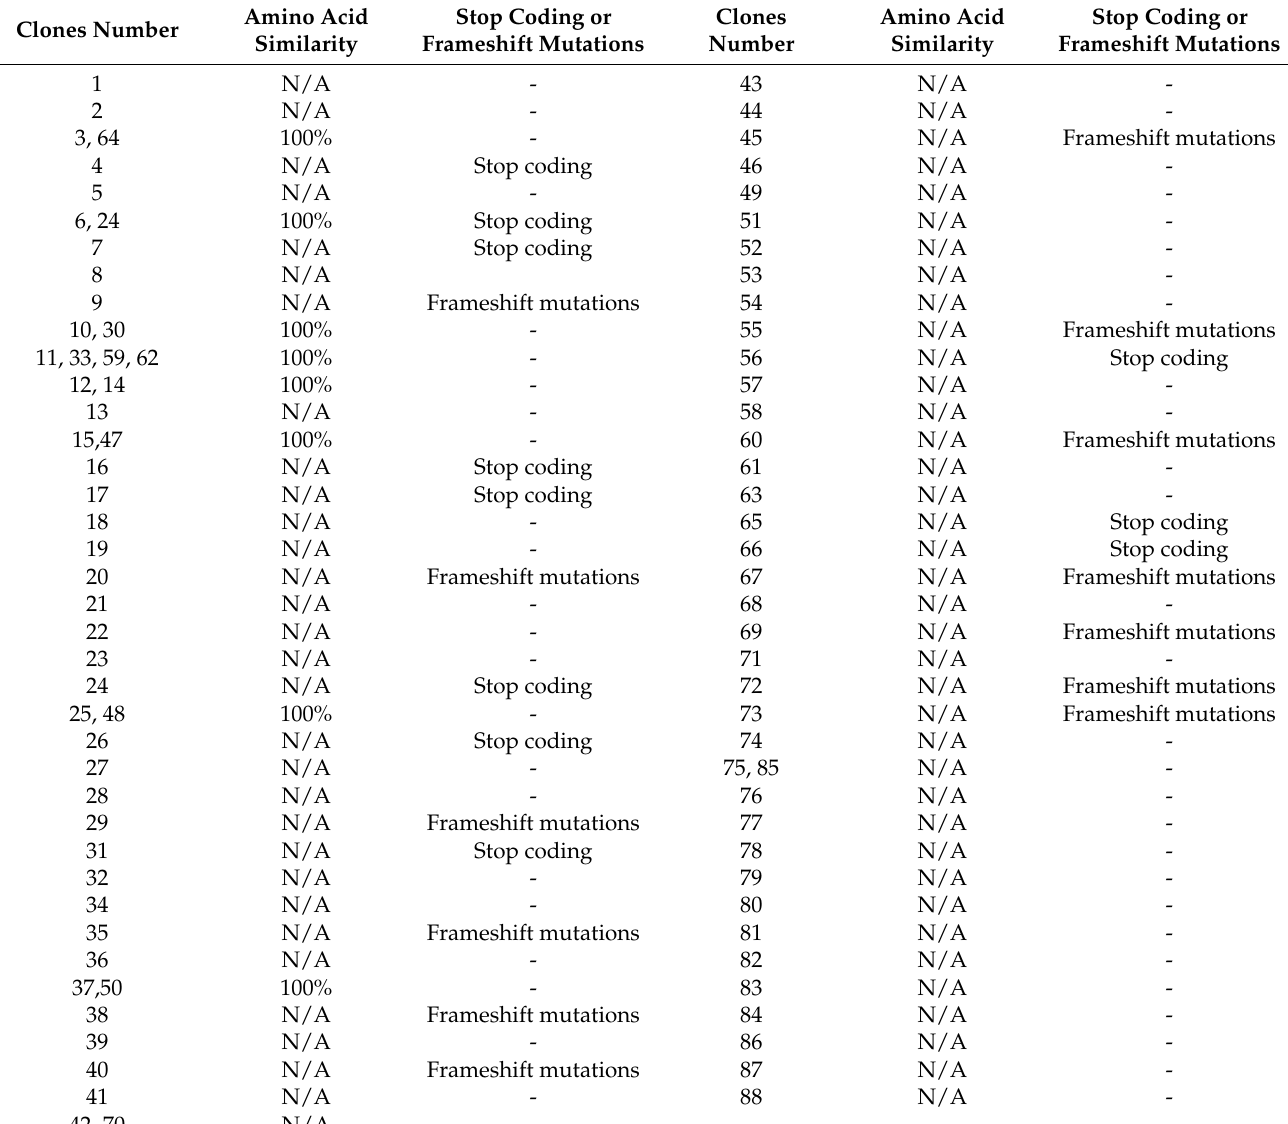
Table 1. Classification of PCR products into families based on amino acid